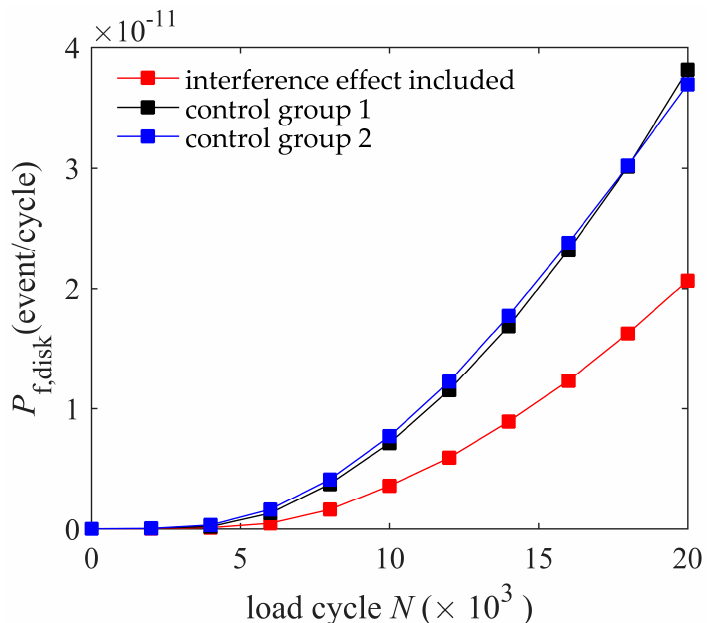
Figure 8. Disk failure risk with different load cycles.